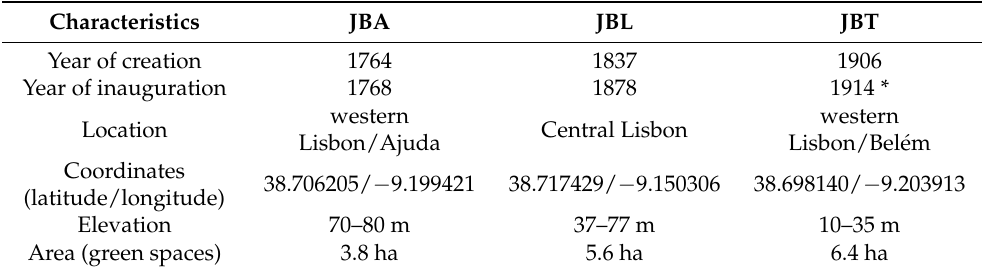
Table 2. General characterization of each garden of Lisbon (JBA—Botanical Garden of Ajuda; JBL— Lisbon Botanical Garden; and JBT—Tropical Botanical